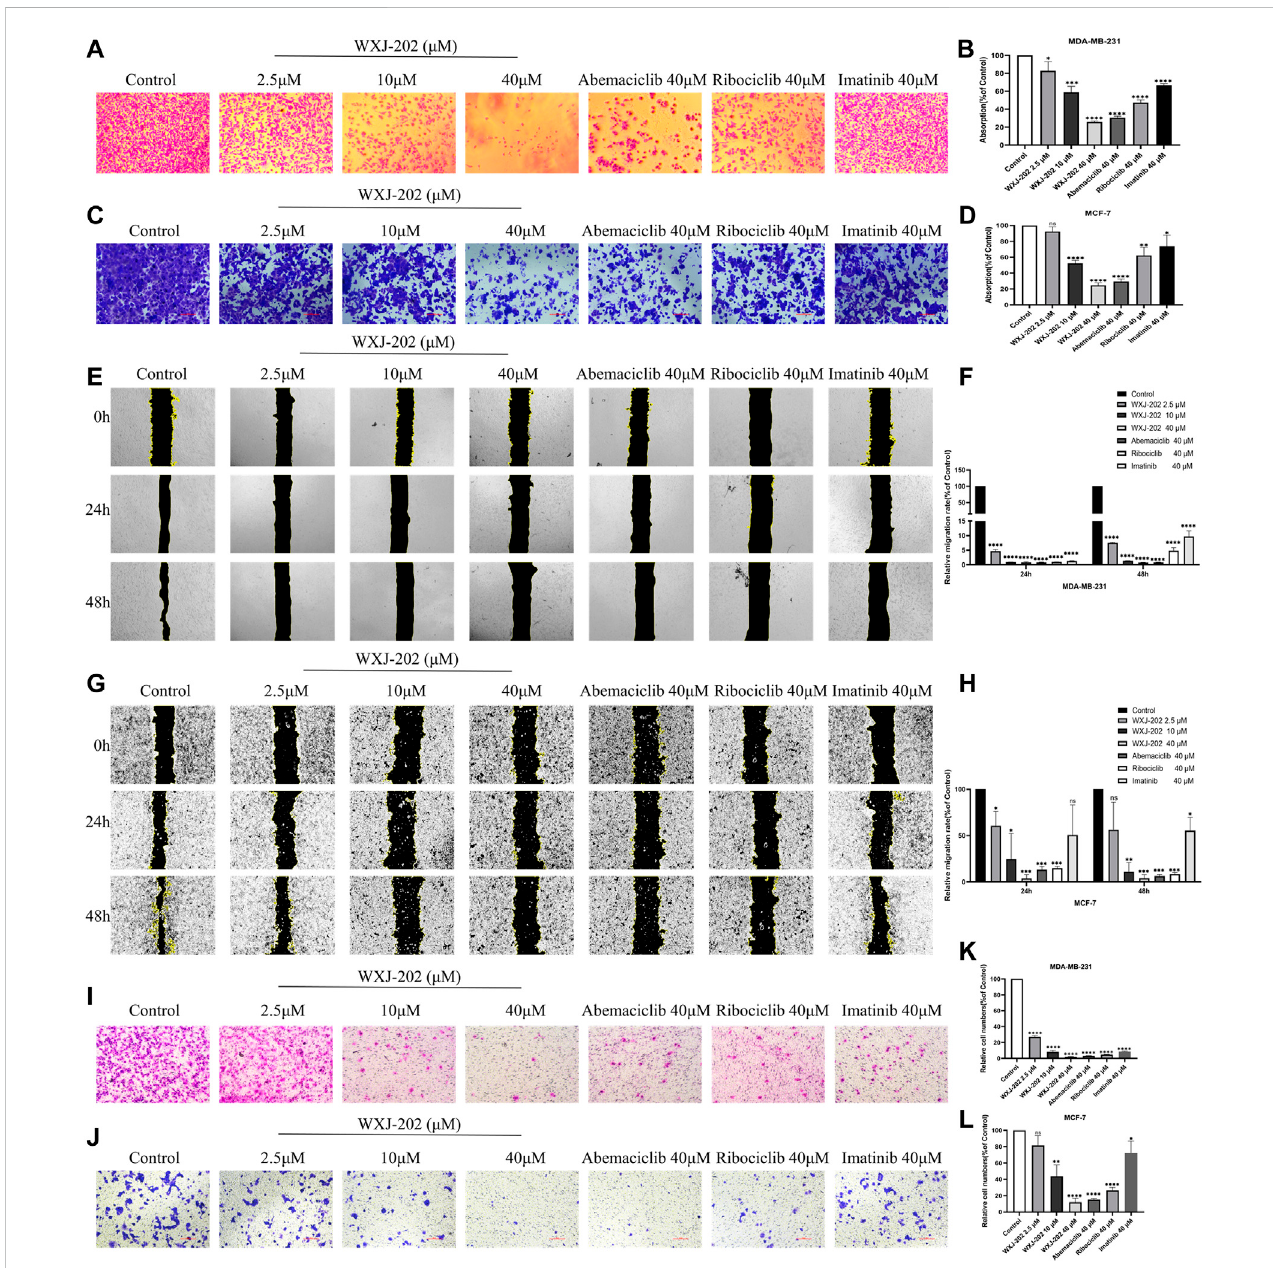
FIGURE 4 EffectsofcompoundWXJ-202ontheadherence,migration, andinvasionofMDA-MB-231 cellsand MCF-7cells. (A – D) Effectsofcompound WXJ-202, abemaciclib, ribociclib and imatinib on the adherence ability of MDA-MB-231 cells and MCF-7 cells. (E – H) The effect of different concentrations of compound WXJ-202, abemaciclib, ribociclib and imatinib on the migration ability of MDA-MB-231 cells and MCF-7 cells. (I – L) Effects of compound WXJ- 202, abemaciclib, ribociclib and imatinib on the invasive ability of MDA-MB-231 cells and MCF-7 cells. * p < 0.05 vs. control, ** p < 0.01 vs. control, *** p < 0.001 vs. control, **** p < 0.0001 vs.